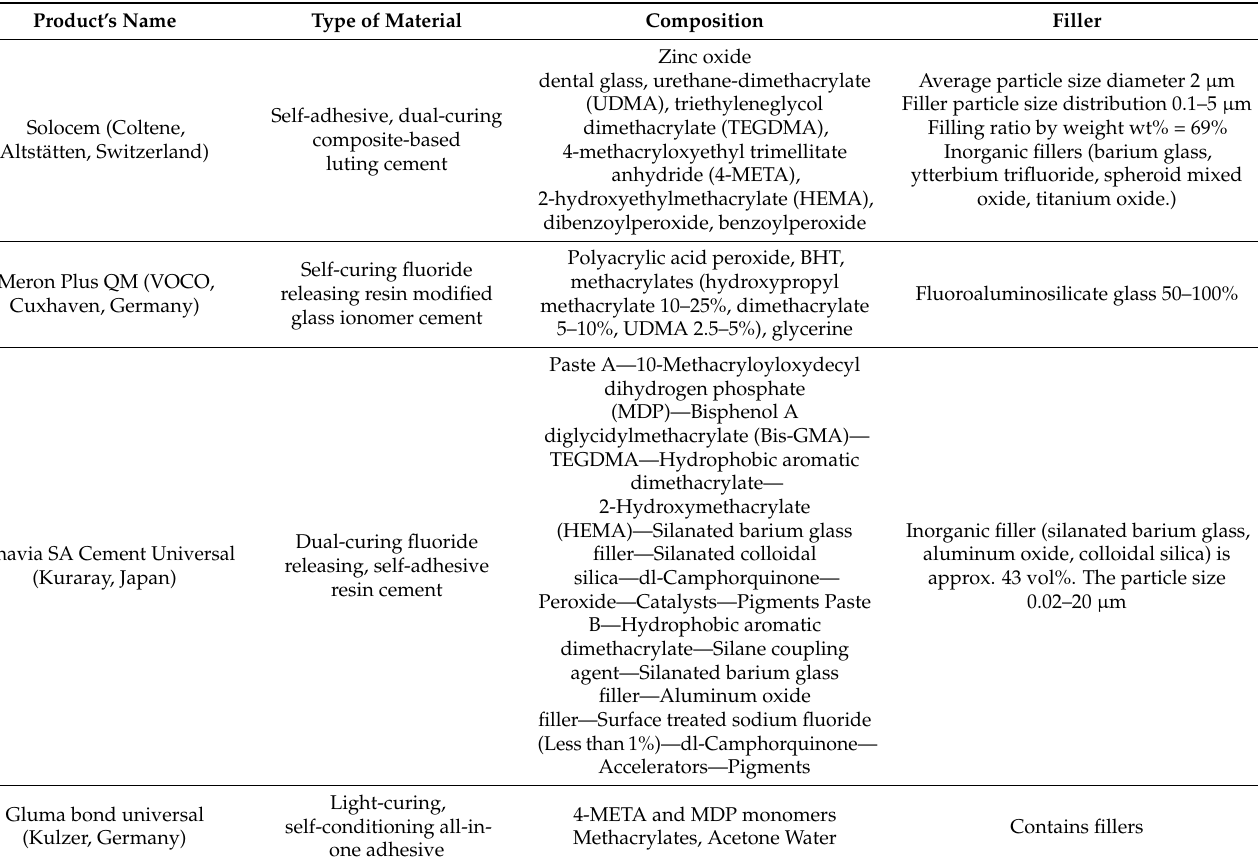
Table 3. Composition of the used commercial